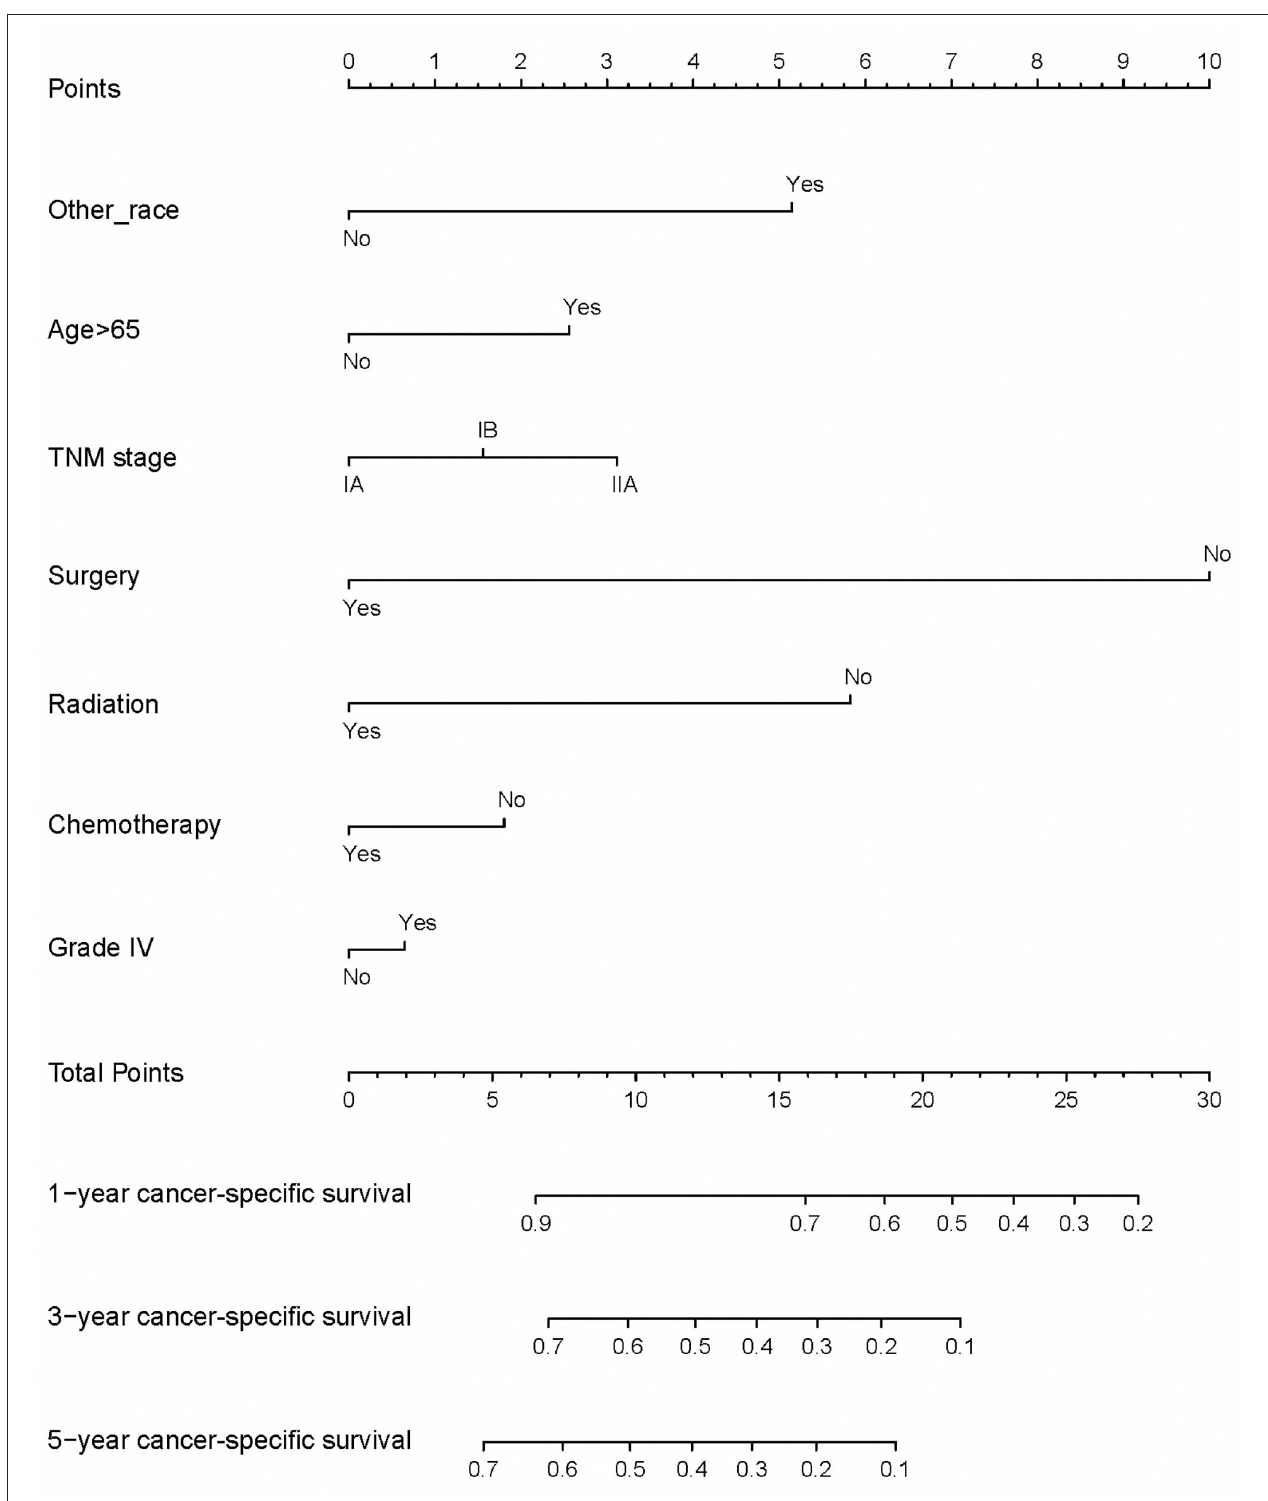
FIGURE 3 | A nomogram is to show the results of multivariate regression.